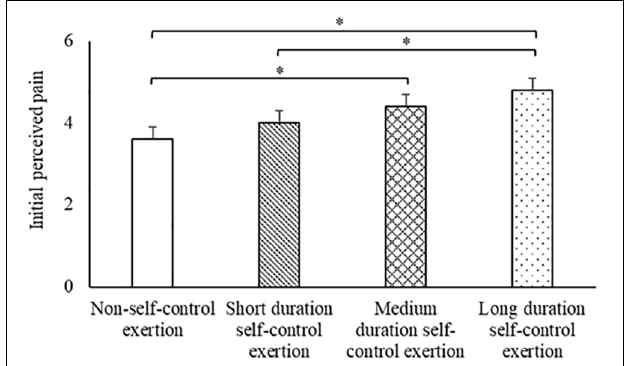
FIGURE 2 | Initial (30 s) perceptions of pain across the trials. Data are mean ± SEM (main effect of trial, p = 0.001; * indicates difference between trials, p <